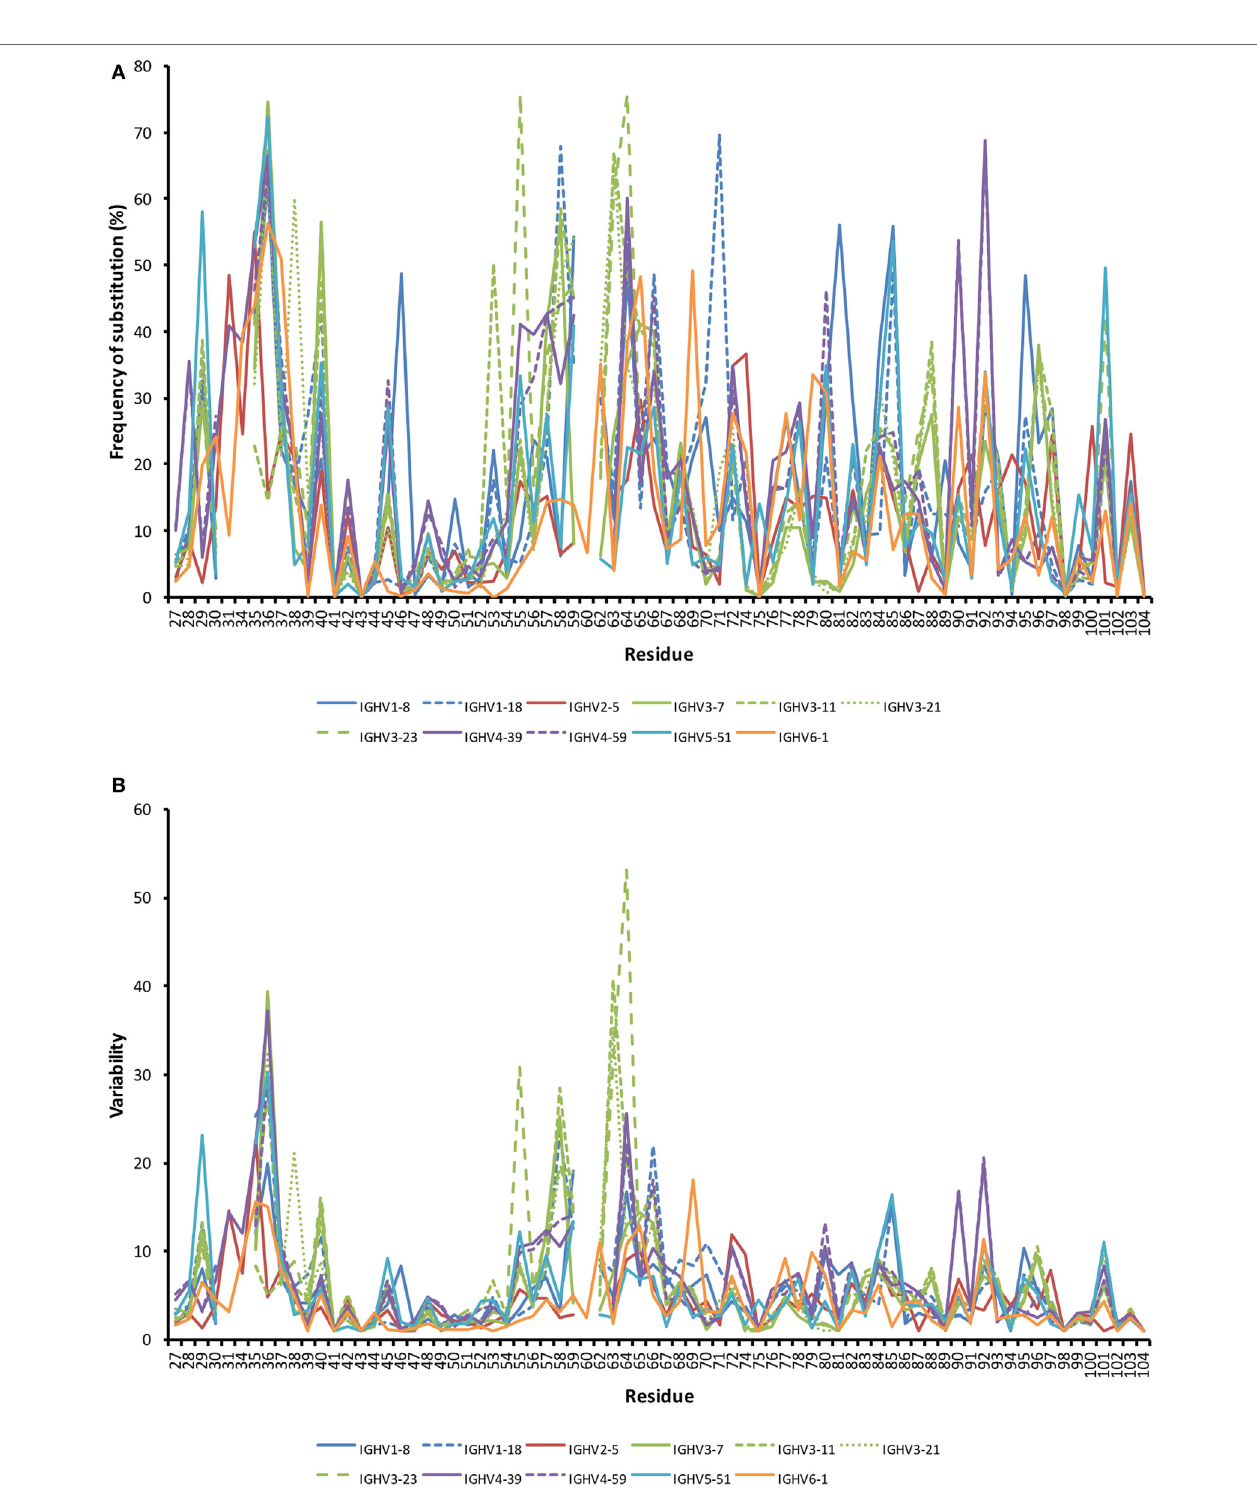
FigUre 2 | Frequency of substitutions (a) and degree of variability (b) of residues encoded by transcripts in bone marrow (BM) with an origin in the 11 investigated germline genes. Residues 27–38 code for complementarity determining region (CDR) 1, while residues 56–65 code for CDR2. Variability was calculated as (the number of amino acids encoded by more than 1% of all reads)/(fraction of reads encoding the most common residue). Only sequences showing no evidence of insertions and deletions were included in the analysis. Numerous residues differed substantially between germline genes in the degree of targeting by substitution. Note the substantial degree of substitution also in some residues of framework region (FR). Frequency of substitution and variability for individual genes are shown in Figure S2 in Supplementary Material.